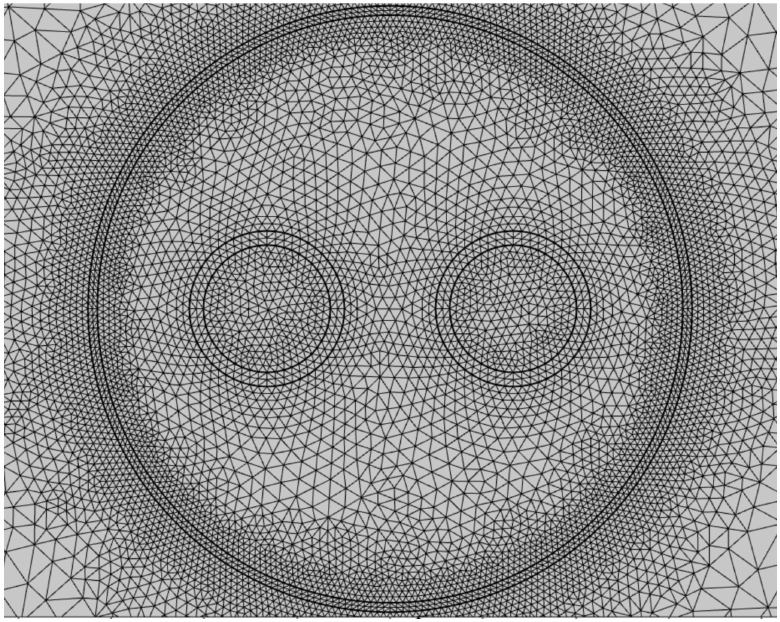
Figure 7. Particular of the mesh employed in the transient simulations performed to estimate k s .